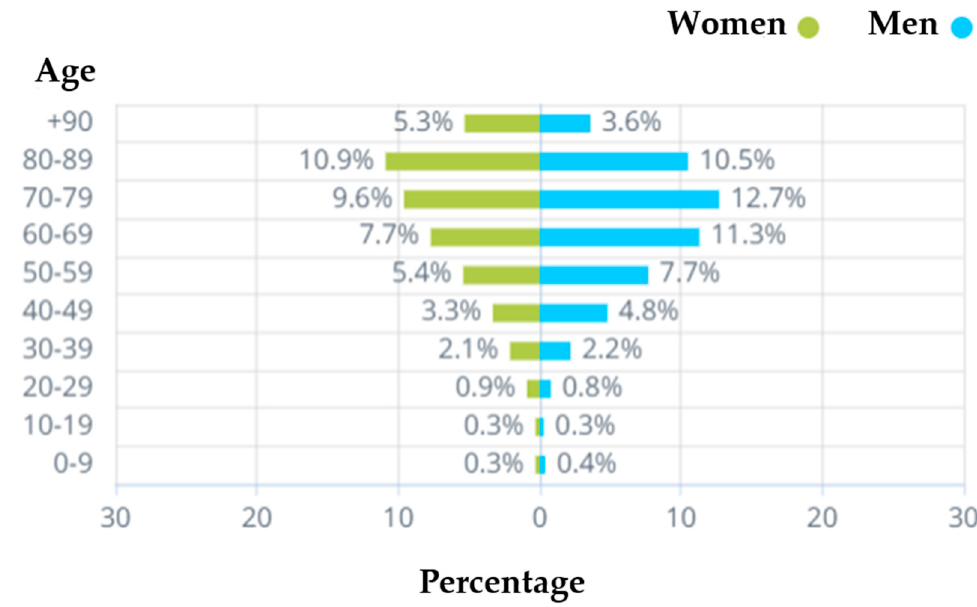
Figure 8. Demographics of severely ill people by age and gender (up to 13 June 2022).